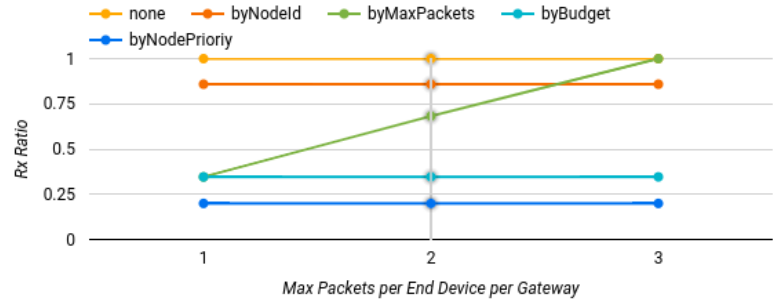
Figure 10. Results of varying the maximum number of allowed packets.